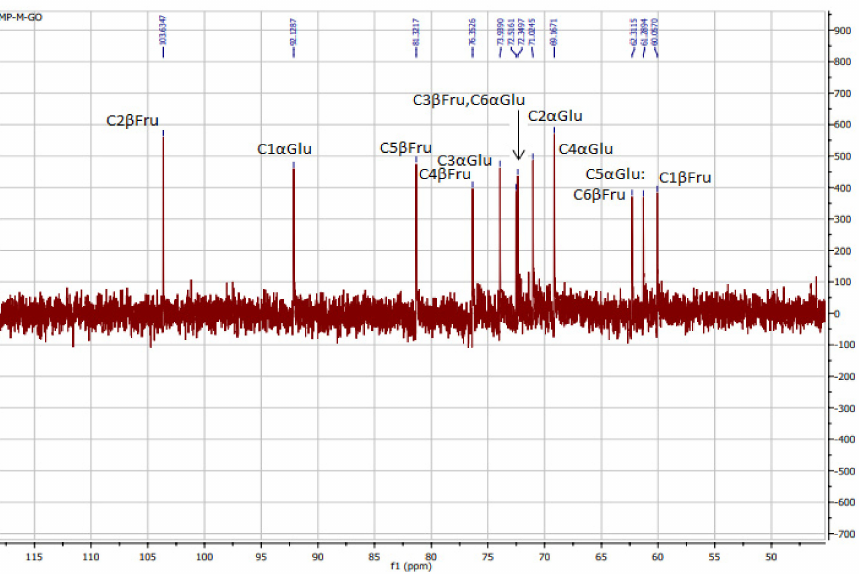
Figure 2. 13 C NMR spectra of polysaccharides from Ceratonia siliqua